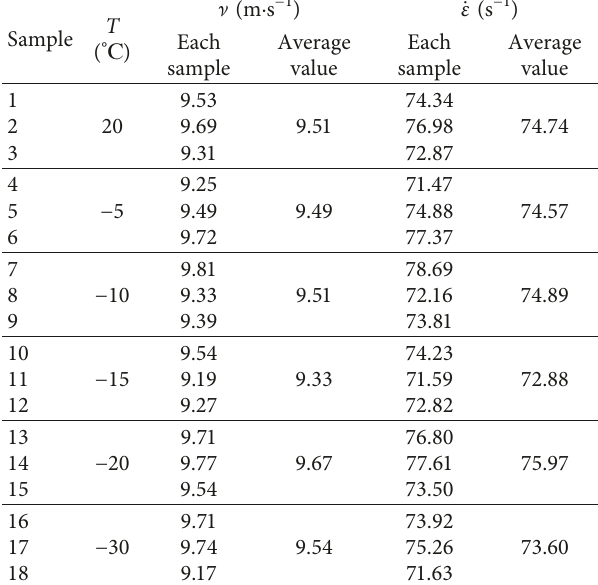
Table 2: Velocity of striker bar ( ] ) and strain rate of specimen ( _ ε ) under different freezing